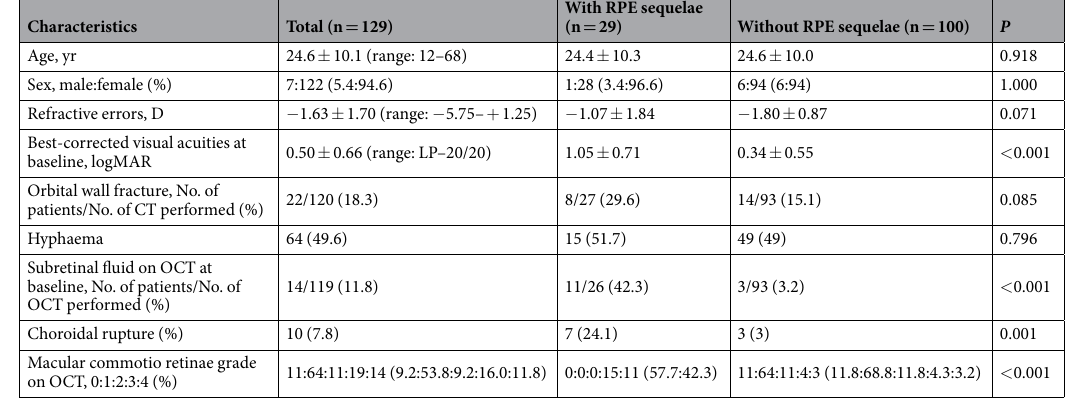
Table 1. Demographic and clinical characteristics of patients with and without retinal pigment epithelium (RPE) sequelae. Data are denoted as number of patients (%) or mean ± standard deviation. CT = computed tomography; LP = light perception; No. = number; OCT = optical coherence